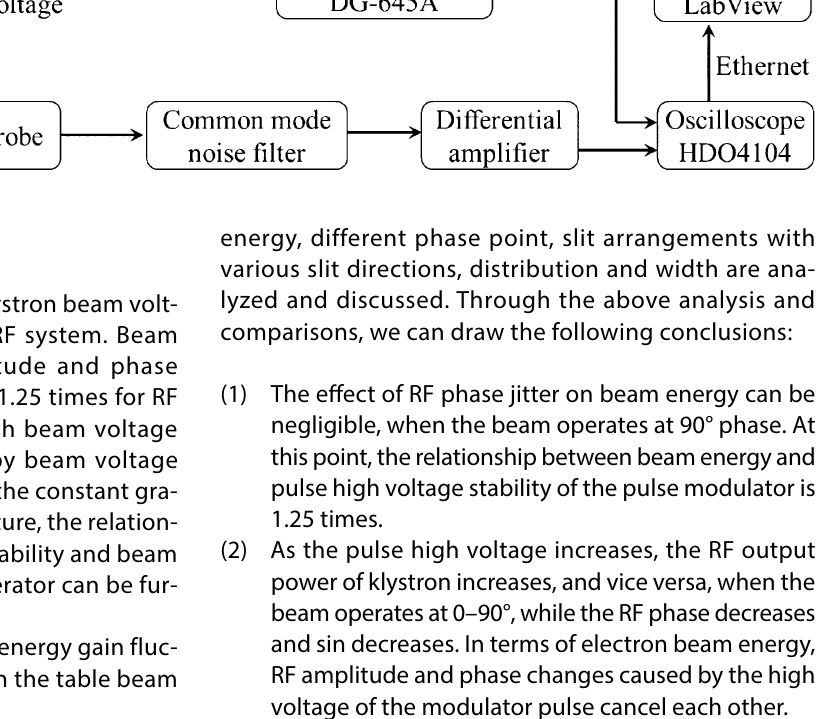
Fig. 10 Pulse-to-pulse stability test system of pulse